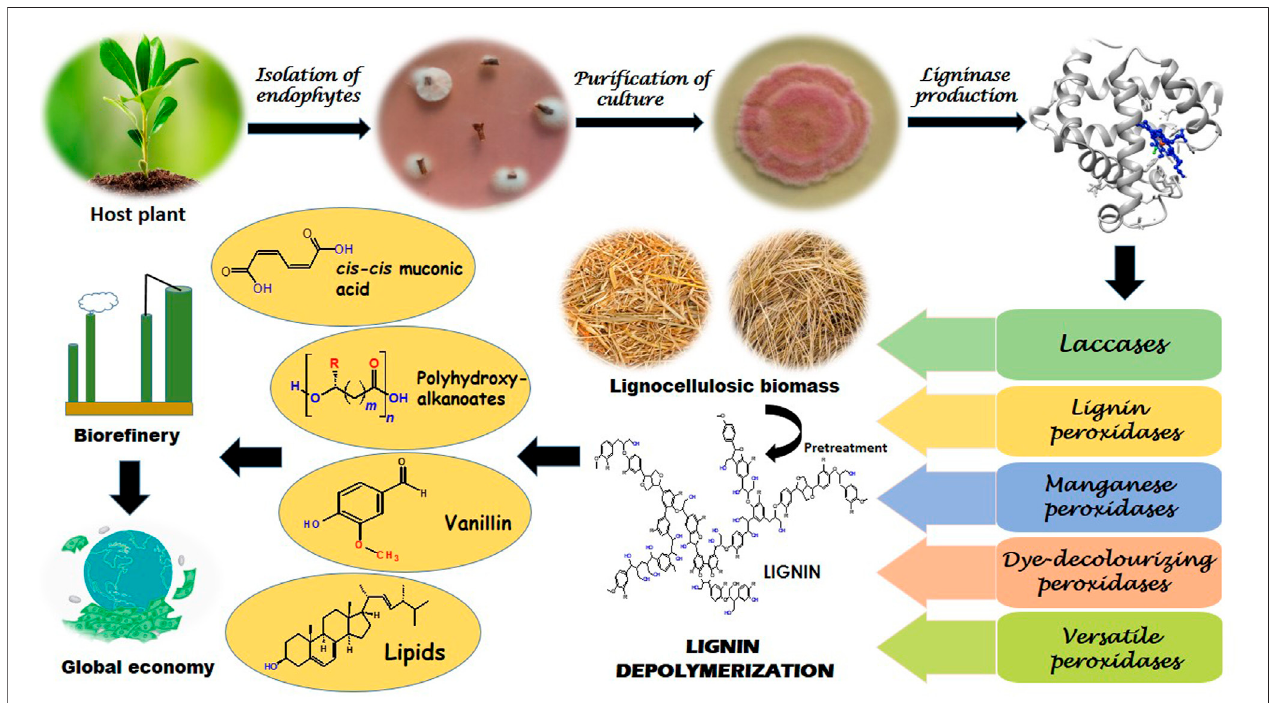
FIGURE 5 | Schematic representation of the process involved in endophytic lignin valorization.